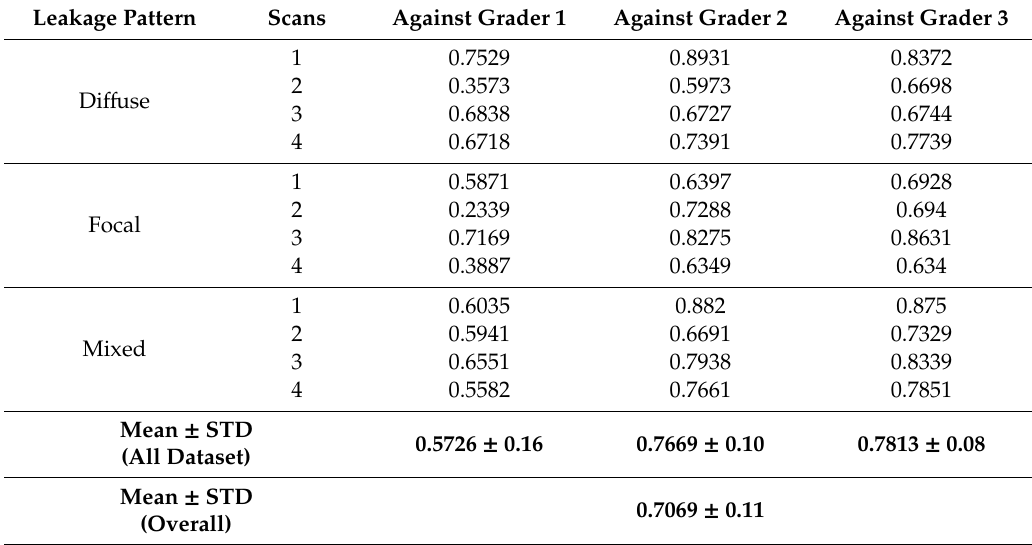
Table 6. Mean dice coe ffi cient for hard exudates segmentation against the expert markings [37]. Leakage